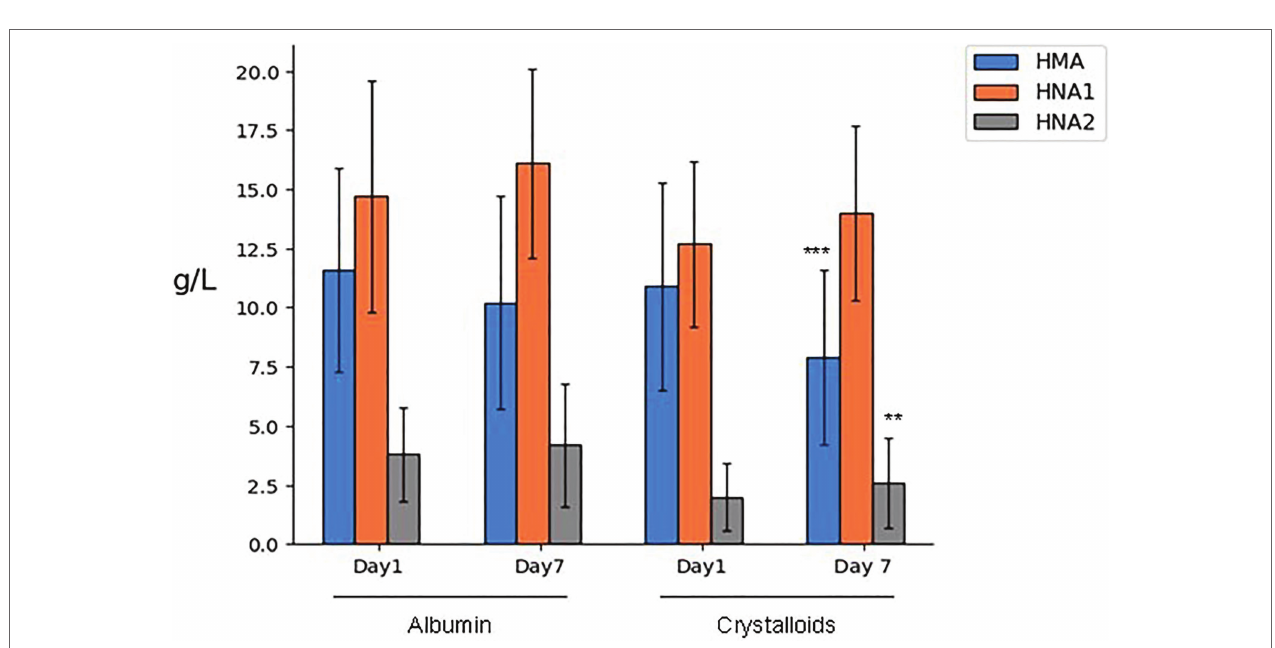
FIGURE 2 | Albumin forms expressed in amounts (g/L) after 1 or 7 days of treatment. Mean ± SD, p for one-way ANOVA: ** p < 0.01 and *** p < 0.001 day 7 vs. day 1, both for albumin- and crystalloids-treated patients. HMA, human mercaptoalbumin; HNA1, reversibly oxidized human non-mercaptoalbumin; and HNA2, irreversibly oxidized human